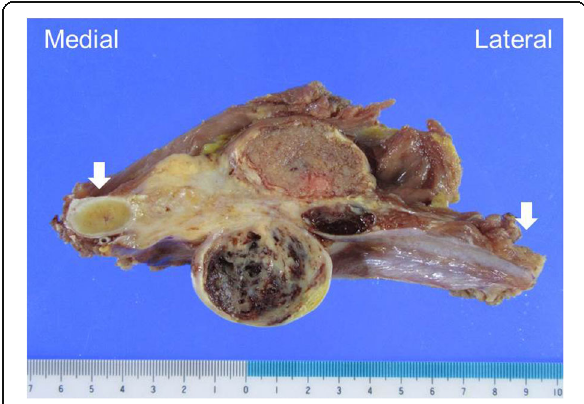
Fig. 2 The resected specimen shows a tumor surrounding the